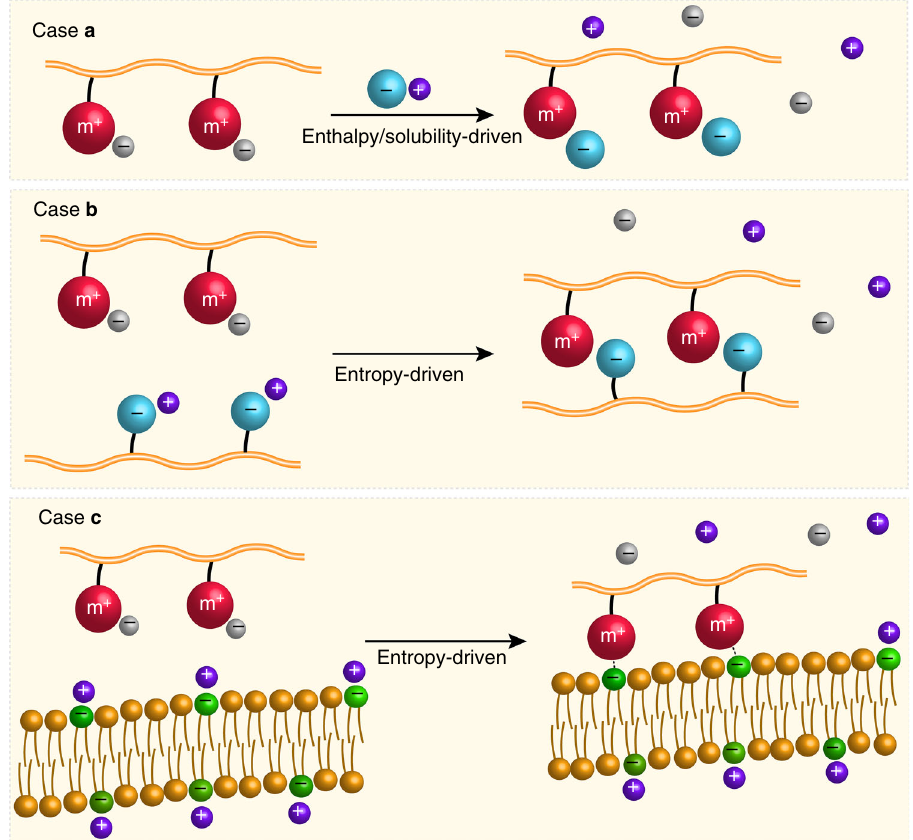
Fig. 3 Metallo-polyelectrolyte interactions with oppositely charged molecular substrates at three different levels. a small molecules, b macromolecules, and c membranes or crosslinked